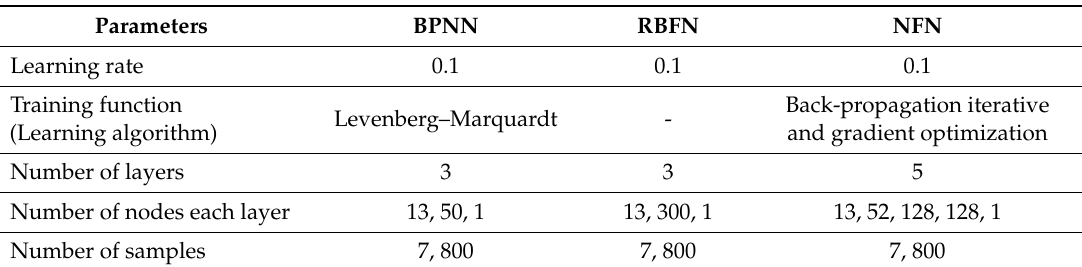
Table 4. The parameter settings of the Back Propagation Neural Network (BPNN), Radial Basis Function Network (RBFN) and NFN.